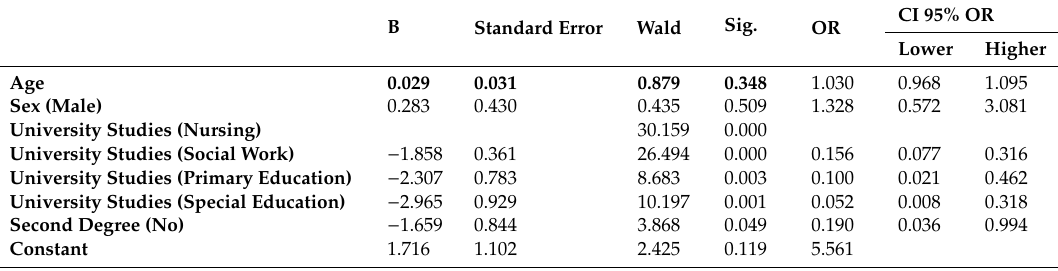
Table 3. Variables associated with su ffi cient health literacy using the binary multiple regression model. CI 95% OR B Standard Error Wald Sig. OR Lower Higher Age 0.029 0.031 0.879 0.348 1.030 0.968 1.095 Sex (Male) 0.283 0.430 0.435